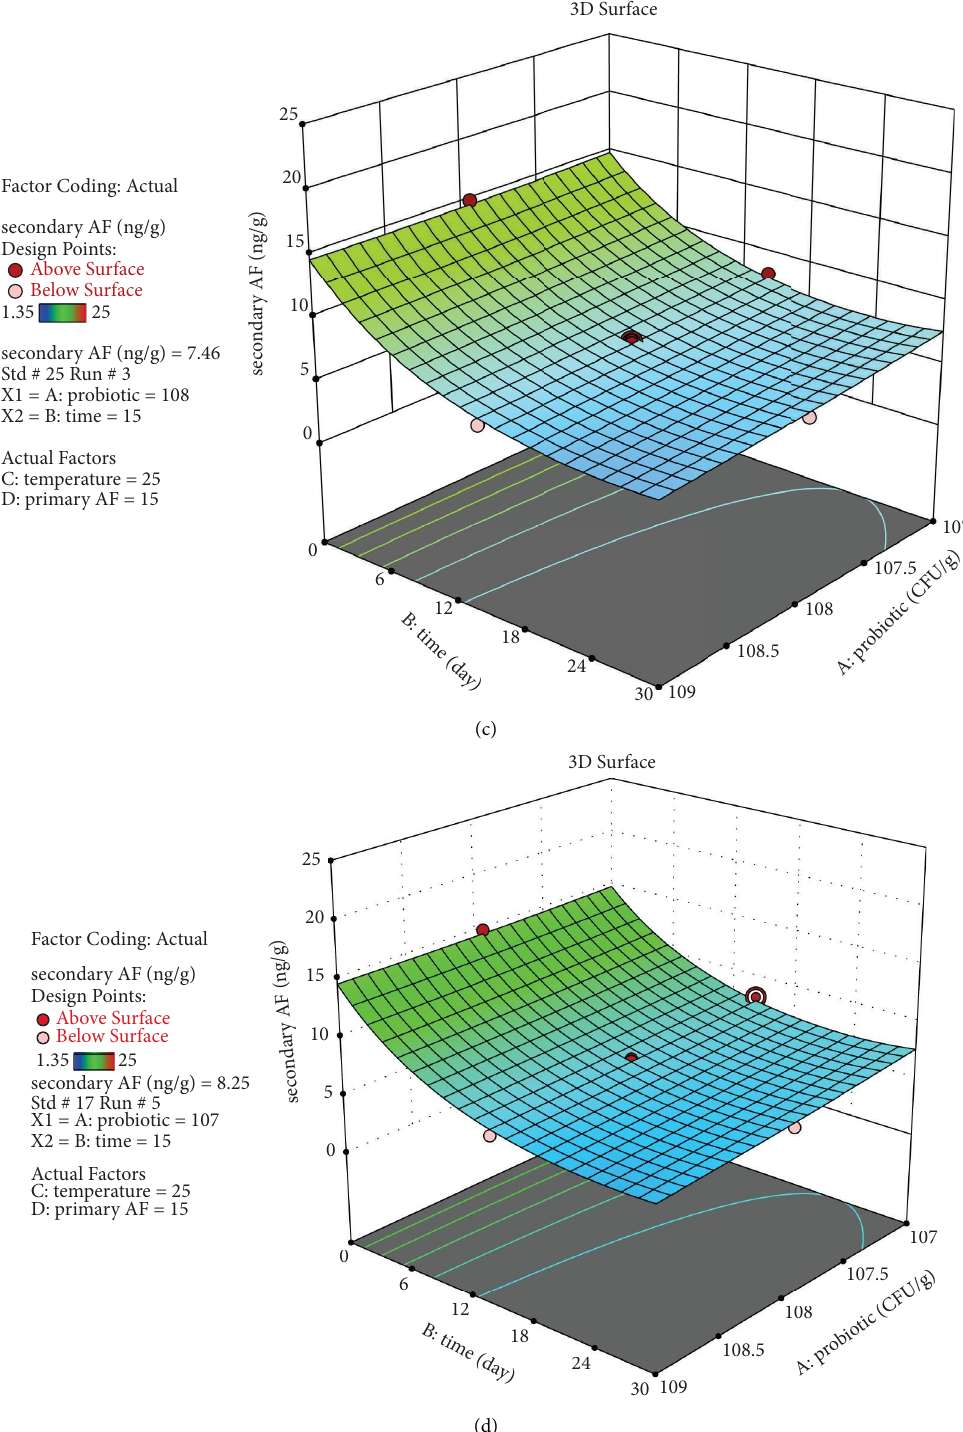
Figure 1: Interaction of storage temperature (25 ° C) and the inoculated afatoxin level (15 ng/g) on the afatoxin residue in pistachio